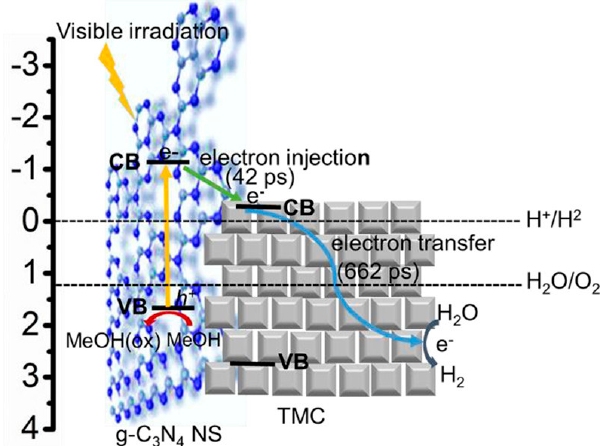
Figure 18. Representative scheme of electron injection and movement in g-C3N4 NS (31 wt %)/TMC during visible-light irradiation [106]. Copyright 2017 American Chemical Society.